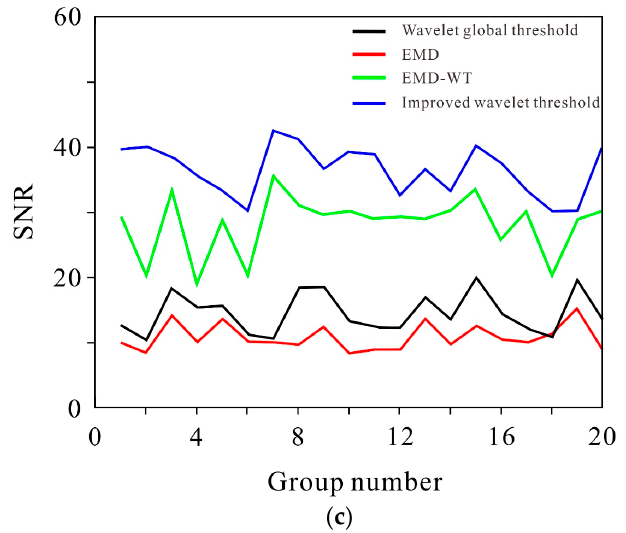
Figure 15. Comparison of the SNR distributions for different types of microseismic data after denoising: ( a ) microseismic noise signal, ( b ) microseismic current signal and ( c ) microseismic signal with noise and current.